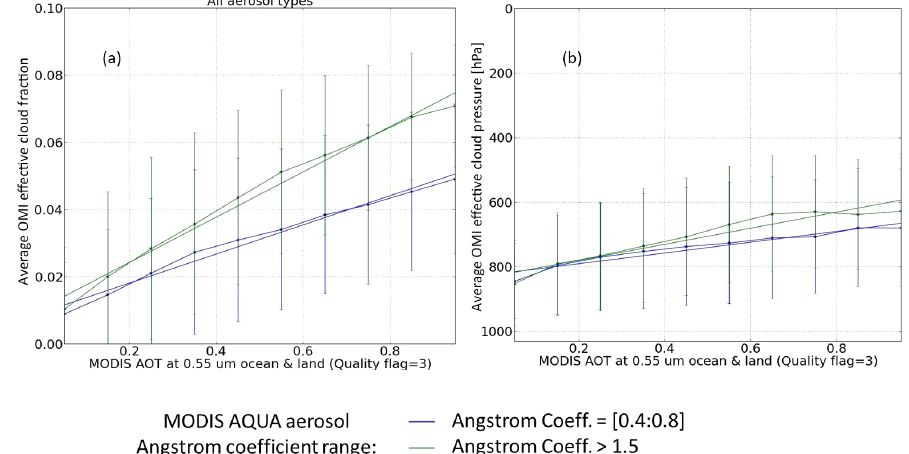
Figure 9. Similar to Fig. 8 but as a function of the MODIS aerosol Ångström coefficient: (a) effective cloud fraction, (b) effective cloud